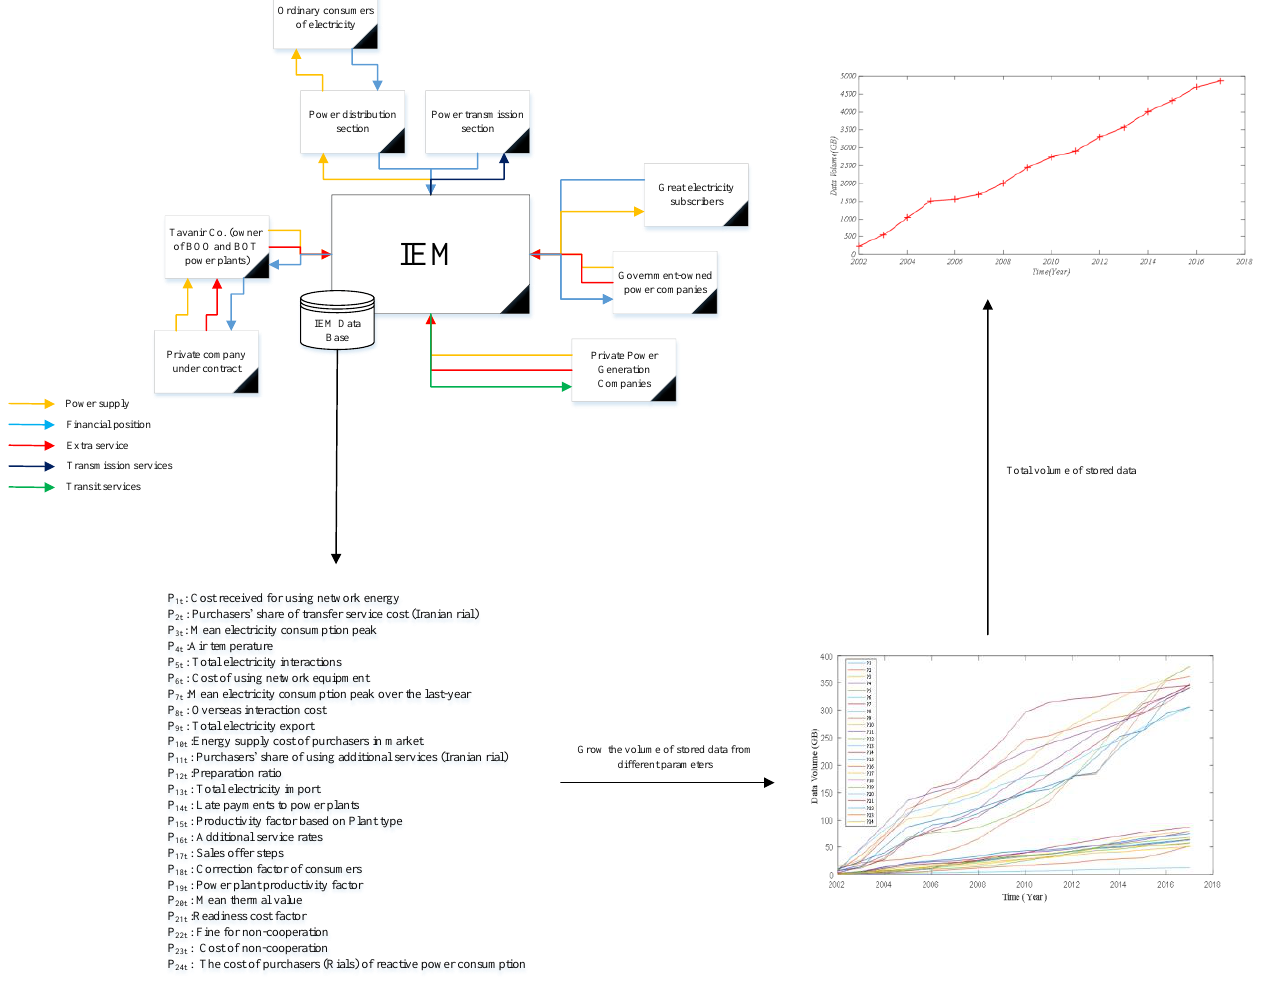
Fig. 6. Electricity market structure and its dataset